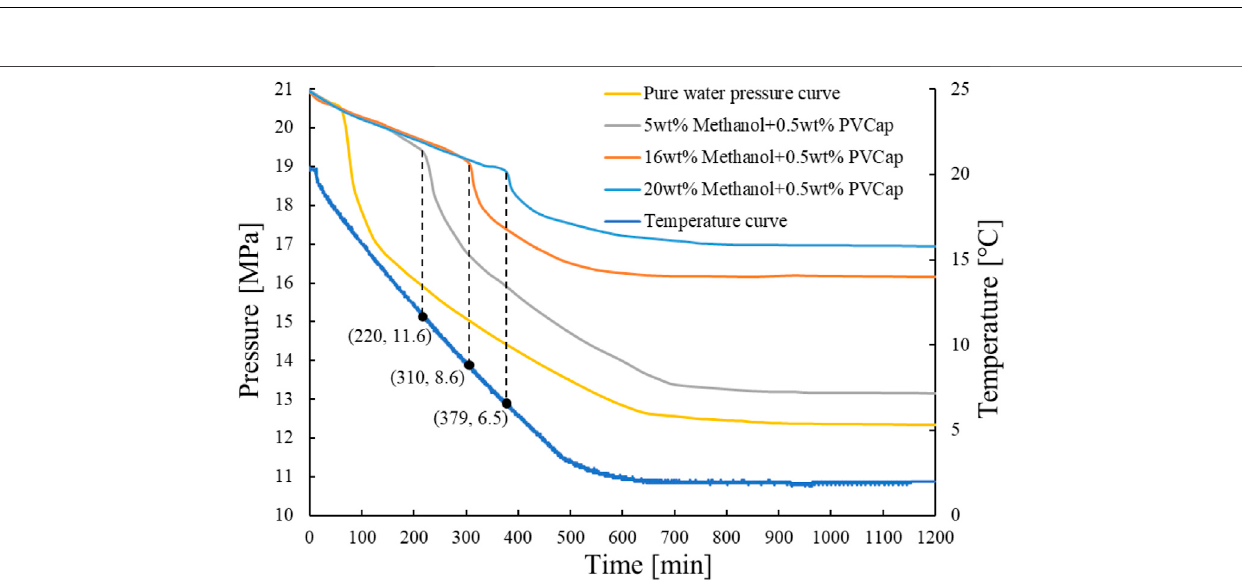
FIGURE 6 | Temperature and pressure distributions in methanol solutions of different concentrations.